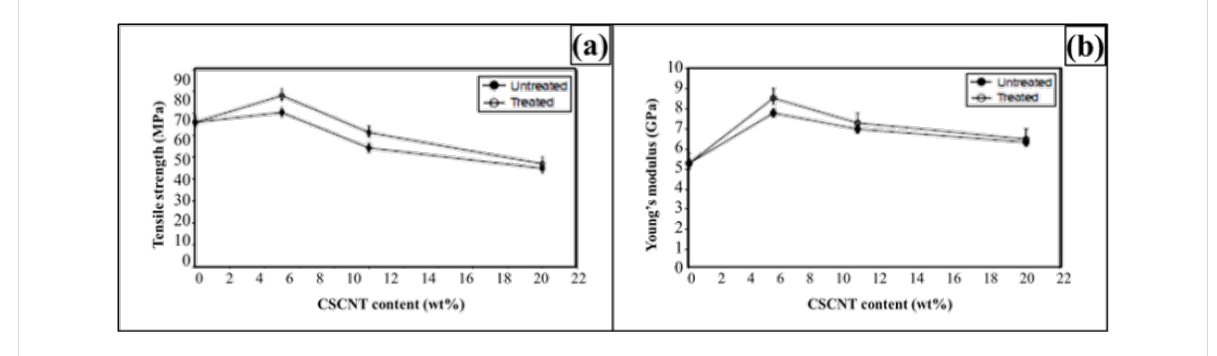
Figure 15: Effect of CSCNT loading on strength and modulus of nanocomposites. Reproduced with permission from [141], copyright 2009 Elsevier.